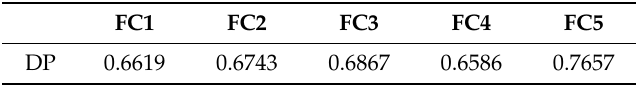
Table 4. Dataset-level precision (DP) using different feature